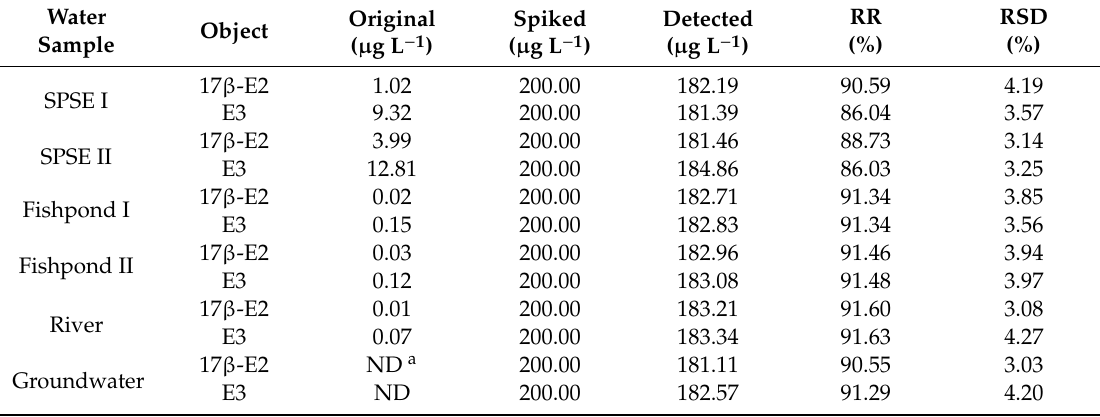
Table 3. Analytical results of natural steroid estrogens in di ff erent real water samples (n = 5).